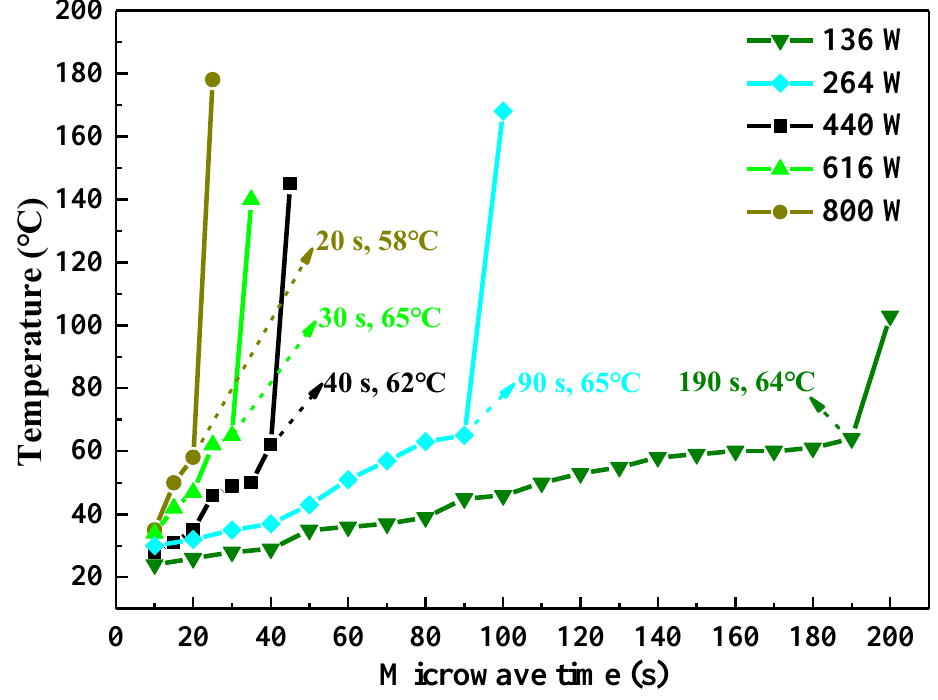
Figure 3. Influence of microwave power and microwave irradiation time on temperature of UPR. In order to further analyze the curing process of UPR under microwave treatment, the temperature of the samples after microwave irradiation at 800 W for 30 s was monitored, and the temperature data were shown in Figure 4a. After microwave irradiation for 30 s, with the extension of standing time, the temperature of the sample increased rapidly and reached a maximum of 181 ◦ C at 9 min. At that time, the addition polymerization reaction of the system was accelerated, a three-dimensional network was formed, and a gel phenomenon occurred [33]. Subsequently, the temperature showed an approximately linear downward trend, indicating that the sample can enter the stage of chain growth reactions after 30 s of microwave irradiation. In addition, it can be seen from the thermal imaging photos that the surface temperature of the sample was uniform at different reaction stages (Figure 4a-1–a-3). It demonstrated that the microwave radiation could make the UPR sample evenly heated, so that the system was cured as a whole. In contrast, it can be seen from Figure 4b that the temperature curve of the sample under thermostatic heat treatment showed three obvious stages. In the first stage, the temperature of the sample increased slowly due to the heat transfer. Eventually, it entered the stage of chain growth reactions after being heated for about 24 min, which was much slower than that of the